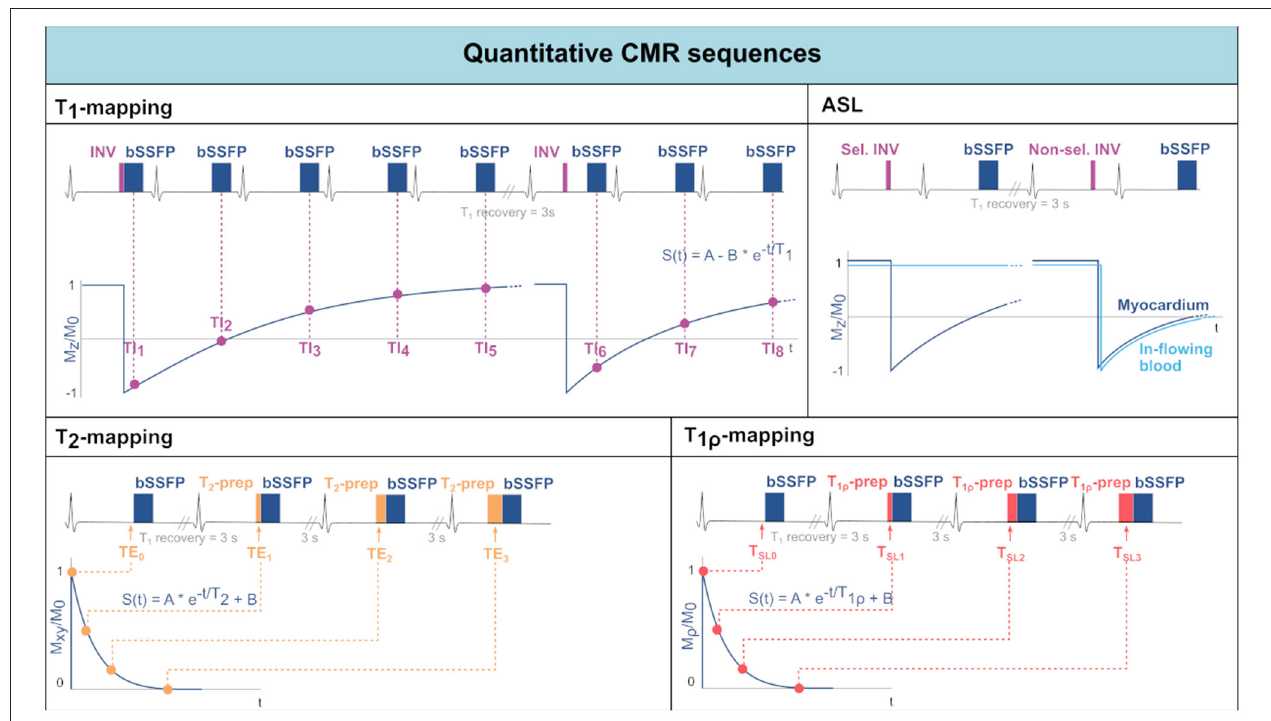
FIGURE 2 | Acquisition schemes for quantitative CMR techniques: T 1 -mapping, Arterial Spin Labeling (ASL), T 2 -mapping, and T 1 ρ -mapping. For each technique, the sequence scheme is represented along with the data sampling and reconstruction strategies.